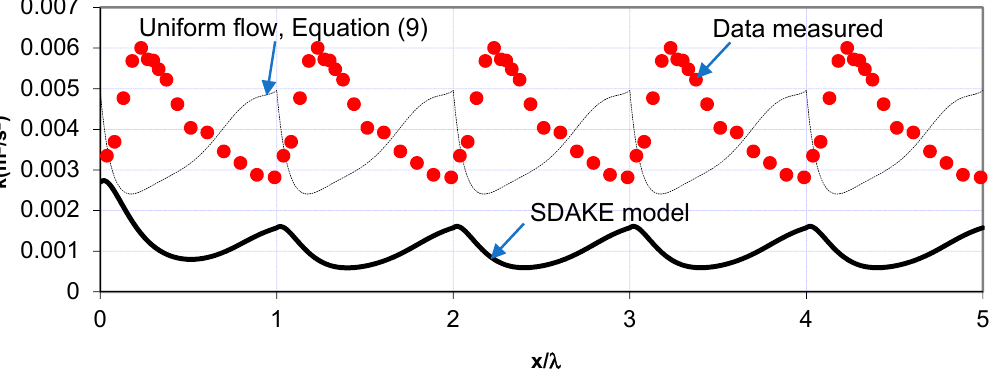
Figure 4. Spatial distribution of depth-averaged turbulent kinetic energy. The graph also shows a comparison between different models with data from experiment (T5).